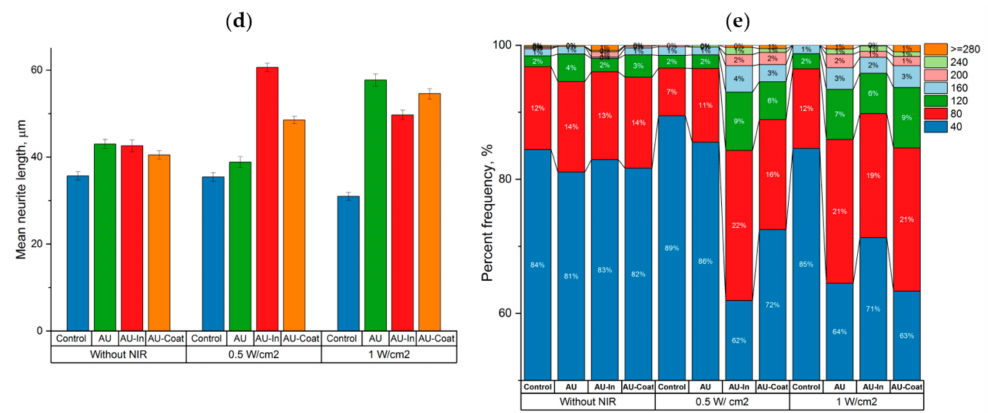
Figure 6. Neuronal differentiation of SH-SY5Y neuroblastoma cells grown on different scaffolds with/without NIR stimulation. Representative epifluorescence images of the SH-SY5Y cells 2 days after NIR stimulation (0.5 W/cm 2 for 5 min) stained for β 3-tubulin in green, phalloidin (as an actin network marker) in red, and nuclei in blue ( a ). Arrows show the direction of fiber orientation. Scale bar—50 µ m. Representative angular distribution of fibers and cell neurites on scaffolds after NIR irradiation (808 nm) at 0.5 W/cm 2 for 5 min ( b ). Comparison of the percentages of differentiated β 3-tubulin-positive SH-SY5Y cells ( c ; values represent the means ± SD; * statistically significant difference, p < 0.05), mean neurite length ( d ; values represent the means ± SE) and frequency distribution of the neurite length ( e ), (each color represents the percentage of neurite frequency given length per